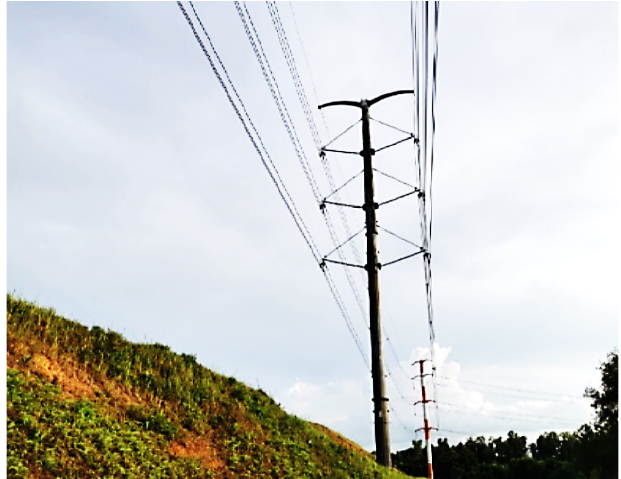
Figure 6. An example of TNB’s compact composite tower line erected in Cyberjaya Selangor [25]. The history of the advancement in insulated cross-arm technology in the transmission lines is shown in Table 2. Table 2. History of insulated cross ‐ arm Technology.